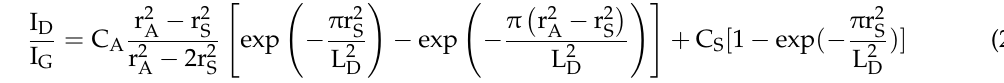
Figure 7. ( a ) Raman spectra of the graphene in G-M contact windows with/without He + bombardment